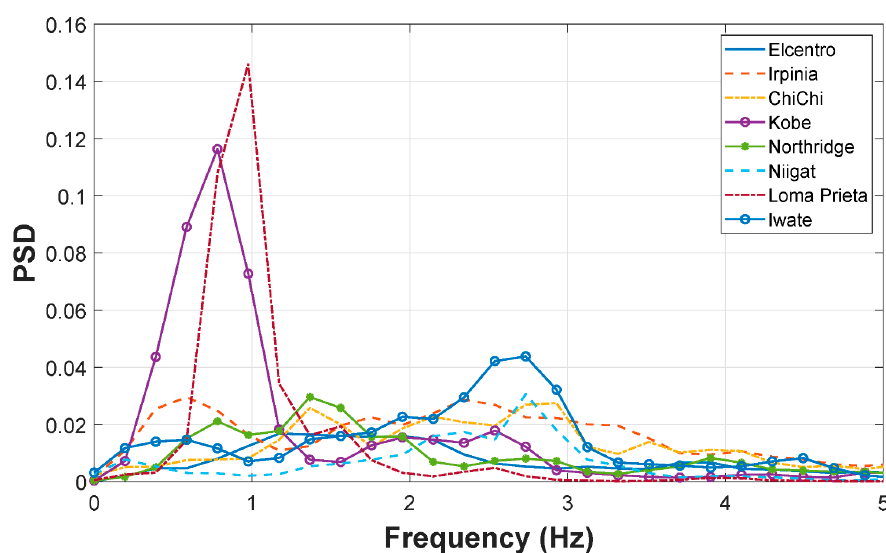
Figure 8. Power spectral densities of ground